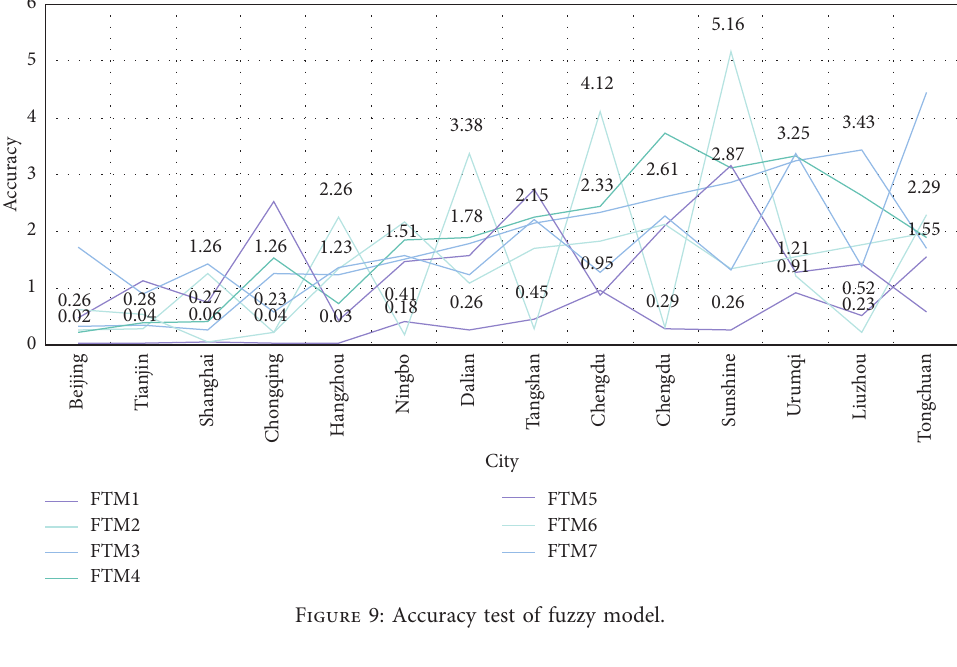
Figure 9: Accuracy test of fuzzy model.